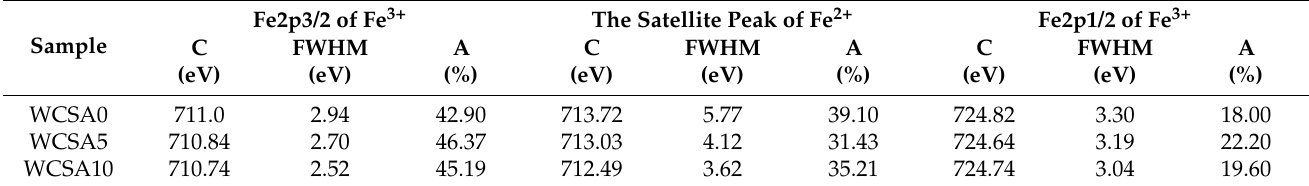
Table 4. Peak center (C), FWHM, and relative area (A) from the curve fitting of Fe2p.